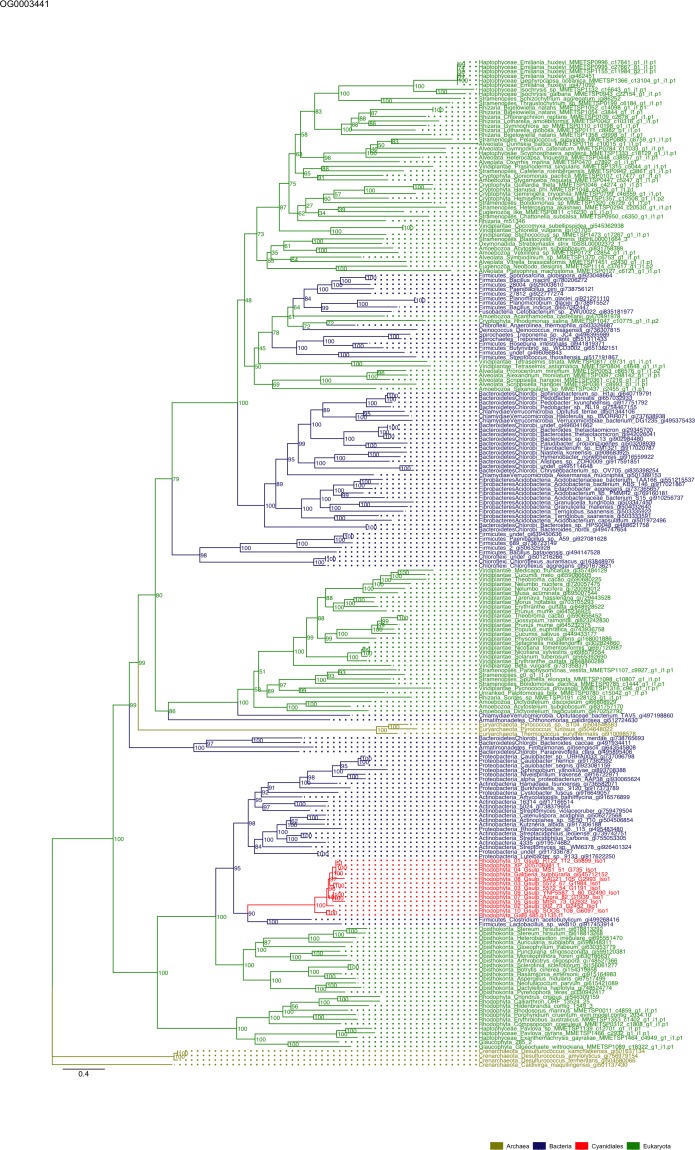
Sequence tree of orthogroup OG0003441.The tree is based on amino acid sequences. Archaea (yellow), Bacteria (blue), Cyanidiales (red), Eukaryotes including other red algae (green). Branches containing Cyanidiales sequences are highlited in red.